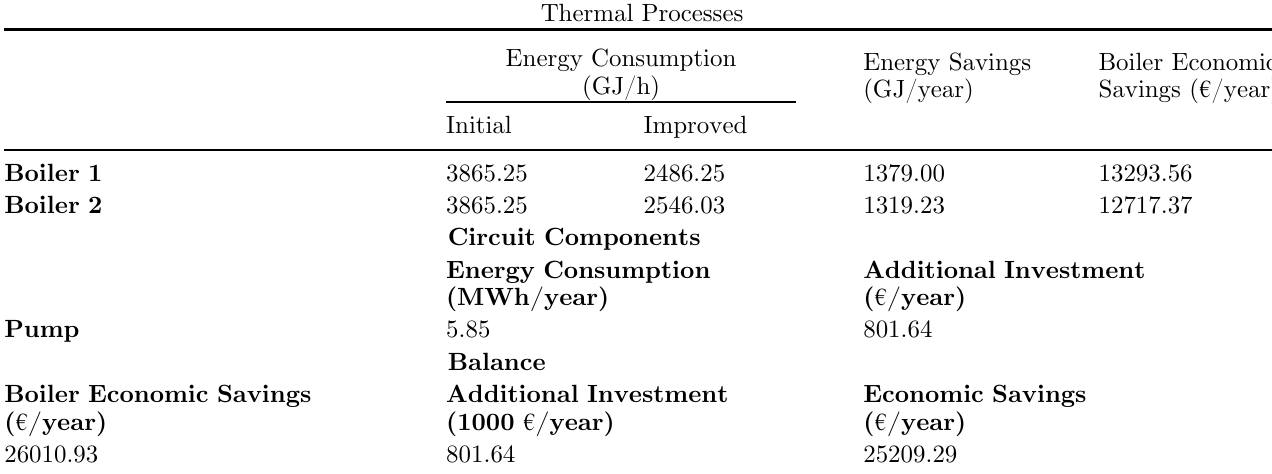
Table 6. Determination of energy and economic savings.